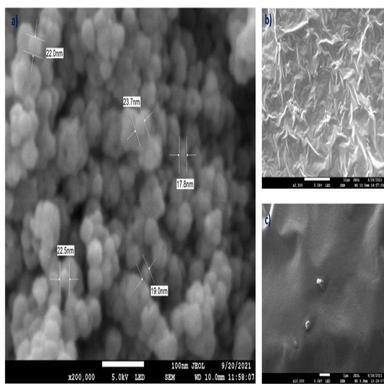
FESEM pictures of (a) TiO2 nanoparticles, (b) Eutectic PCM, (c) NeUPCMs.